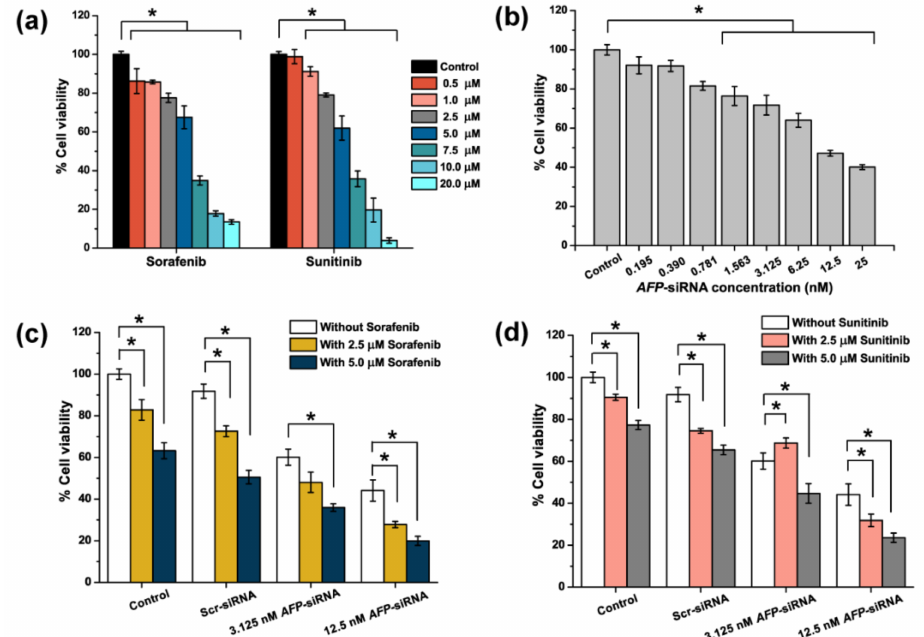
Figure 1. Evaluation of the effect of using antiangiogenetic drugs and/or AFP -siRNA on HepG2 cell viability. ( a ) Percentage of cell viability of HepG2 exposed to different concentrations of sorafenib and sunitinib for 24 h. ( b ) Percentage of cell viability of HepG2 exposed to different concentrations of AFP -siRNA for 48 h. ( c ) Percentage of cell viability of HepG2 exposed to different concentrations of AFP -siRNA followed by sorafenib. ( d ) Percentage of cell viability of HepG2 exposed to different concentrations of AFP -siRNA followed by sunitinib. Control (untreated cells) and Scr-siRNA were used as control. Significance was set at p -values of p < 0.05 and indicated with an asterisk (*). The transfected AFP -siRNA using Lipofectamine 2000 at final concentrations of 0.195, 0.390, 0.781, 1.563, 3.125, 6.25, 12.5, and 25 nM for 48 h was performed to evaluate